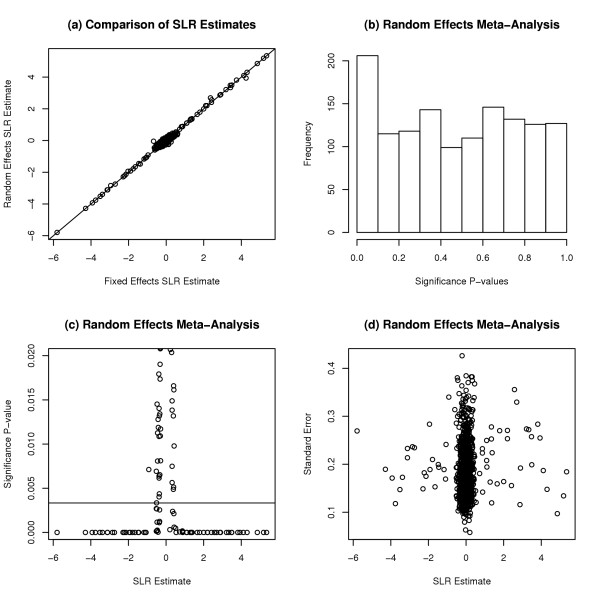
Random effects meta-analysis of simulated results. (a) A comparison of the fixed effects and random effects meta-analysis estimates of SLR shows general agreement between the models. (b) The histogram of significance P-values shows an abundance of significantly differentially expressed genes, as evidenced by the large number of smaller significance P-values. (c) The smallest significance P-values tended to occur for genes whose random effects meta-analysis SLR estimates were large in absolute value. The reference line is the P-value cut-off used to control the False Discovery Rate at 0.05. Using this cut-off, the random effects meta-analysis declared 72 of the 1322 genes significantly differentially expressed. (d) Demonstration of how the SLR's estimated from the meta-analysis relate to their standard errors.